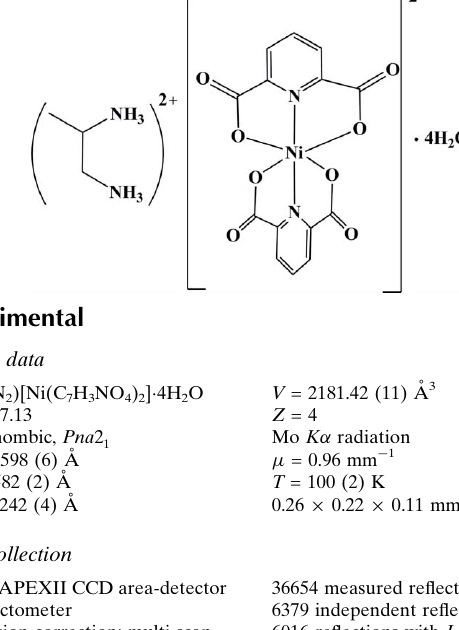
36654 measured reflections 6379 independent reflections 6016 reflections with I > 2 (cid:1) ( I ) R